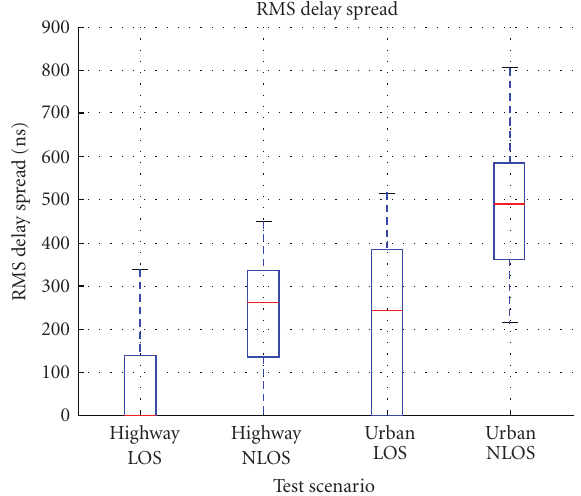
Figure 4: Comparison of RMS delay spread for various scenarios.